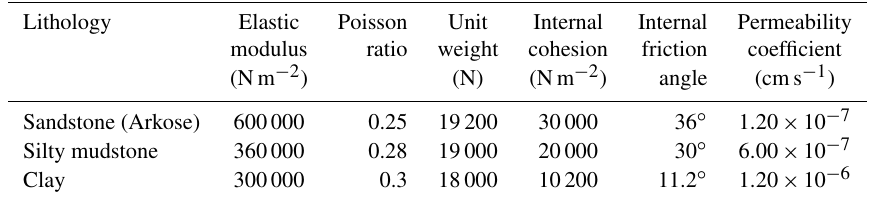
Table 4. Mechanical parameters of the geomechanical model. Lithology Elastic